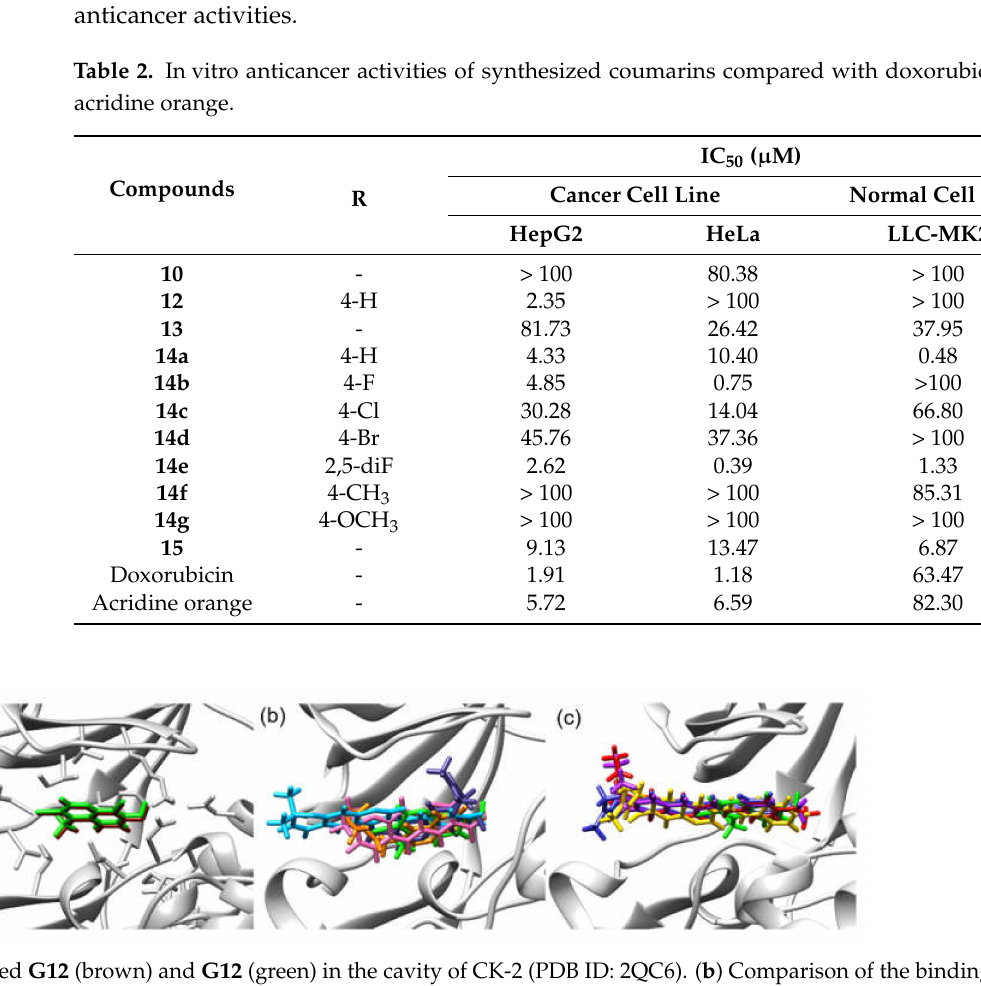
Figure 2. ( a ) Redocked G12 (brown) and G12 (green) in the cavity of CK-2 (PDB ID: 2QC6). ( b ) Comparison of the bindings of 10 (pink), 12 (sky blue), 13 (orange), 15 (violet), and G12 (green) in the CK-2 cavity. ( c ) Comparison of the bindings of 14a (yellow), 14e (blue), 14f (purple), 14g (red), and G12 (green) in the CK-2 cavity (PDB ID: